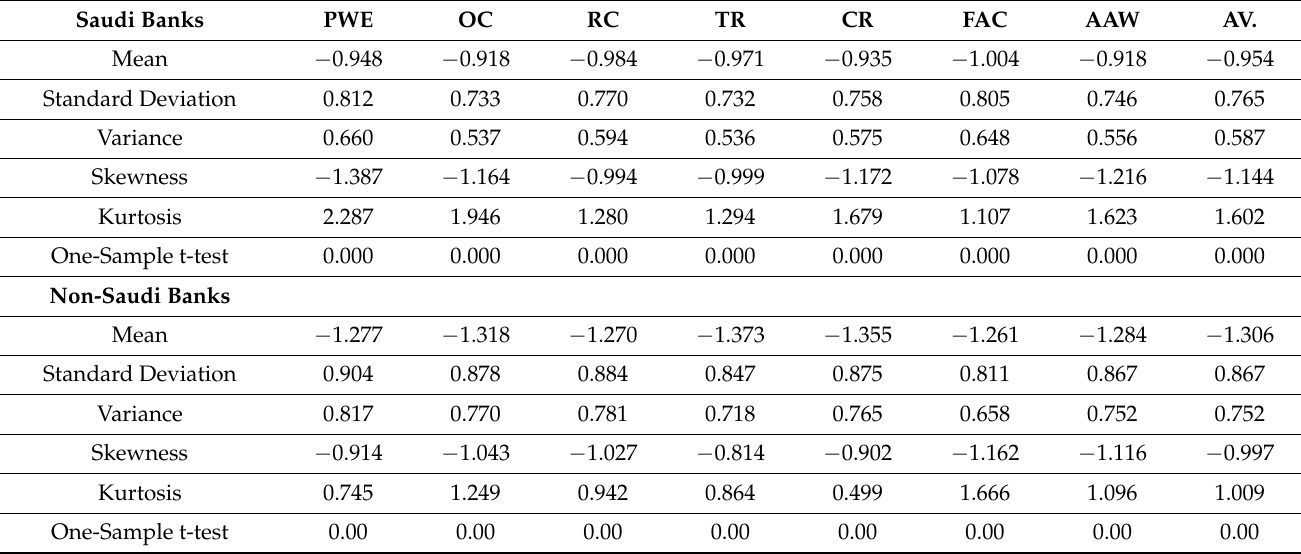
Table 8. Comparison of GQWL between Saudi and non-Saudi banks.